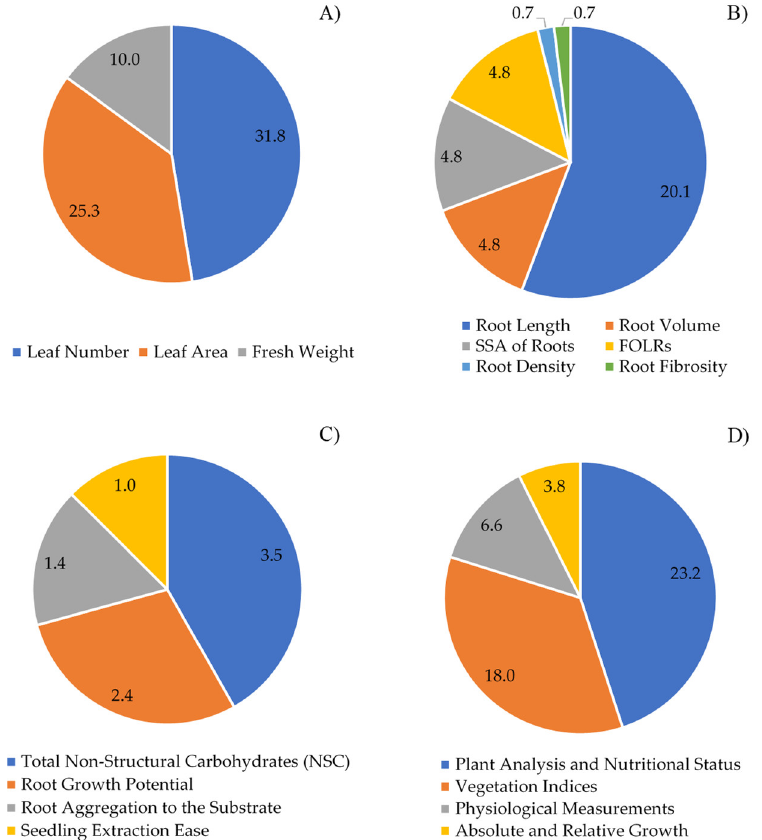
Figure 7. Morphological and physiological parameters and quality indicators referred to in the study database. Morphological characteristics of plants: ( A ) leaf number, leaf area and fresh weight. ( B ) Root length, fibrosity, volume and density, SSA: Specific Surface Area; FOLRs: First Order Lateral Roots. ( C , D ) Different physiological parameters. The values are expressed as percentages ( n = 289). Table 2. Potential tools for prediction of growth, development, survival, vigour, plant performance, and plant quality for a representative sample of forest, fruit, horticultural, aromatic, and ornamental species ( n =